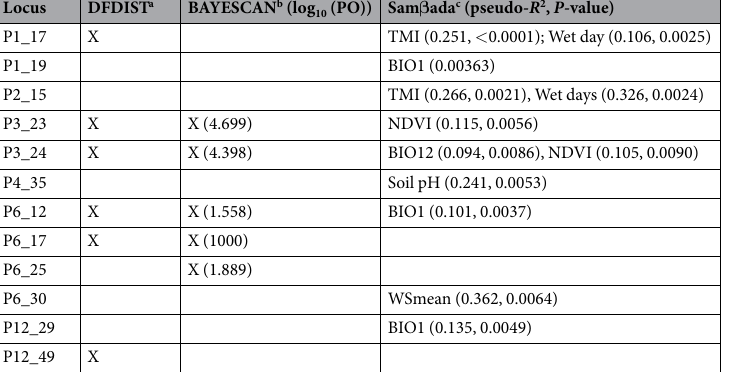
among haplotypes did not fit tightly with a population in the expansion model (Kolmogorov-Smirnov test, P < 0.001, Supplementary Fig. S1), which indicates diminishing populations or structured sizes of M. basjoo var. formosana 53, 54 . In un-subdivided populations, molecular signature characteristics of sudden expansions might not be observed, even when populations had expanded by several orders of magnitude after the LGM 55 . Although no consistent evidence for population growth was found for individual populations, our results showed evidence for historical spatial range expansion in pooled samples because of significant negative values of neutrality test statistics (Tajima’s D = − 1.6544, P = 0.015; Fu’s F s = − 6.8767, P = 0.008) (Table 2). Moreover, the hypothesis of historical spatial range expansion could not be rejected in pooled samples based on non-significant small rg value ( rg = 0.0697, P = 0.84) 32 , non-significant SSD (SSD = 00096, P = 0.81) 56 , and significant R 2 ( R 2 = 0.0416, P = 0.04) 33 (Table 2). Based on the average F ST value for each population in comparison with the remaining populations, glacial refugia of plant species have been inferred in many plant species in Taiwan. The most divergent populations can be found located in the north-central and south (particularly in the southeastern part) parts of Taiwan for tree species 6 . Populations served as refugia in the north-central part of Taiwan were found for tree species, including T. aralioides 17 , Cu. koinishii 57 , Ca. carlesii 18 , Machilus thunbergii 58 , Ma. Kusanoi 58 , and Ci. kanehirae 6 based on chloroplast DNA variation; and Ci. kanehirae 19 and Quercus glauca 59 based on nuclear DNA variation. Species with southern glacial refugia include Cy. glauca 15 , T. aralioides 17 , Ca. Carlesii 18 , Ma. thunbergii 58 , Ma. Kusanoi 58 , and Ci. kanehirae 6 based on chloroplast DNA variation; and Ci. kanehirae 19 and Q. glauca 59 based on nuclear DNA variation. Our results in M. basjoo var. formosana reflect recolonization events after the latest glacial period that probably originated from the southern population Sandimen due to its highest mean pairwise F ST ( = 0.154) against the remaining populations based on sequence variation of the second intron of Cu/Zn SOD2 (Fig. 3). However, the population Wulai had the highest average F ST based on AFLP variation (Fig. 3) and clearly distin- guished from other populations according to the DAPC genetic clustering analysis (Fig. 4), suggesting that the population Wulai may have been the northern glacial refugium for M. basjoo var. formosana . In comparison with other angiosperm species that occurred in Taiwan, M. basjoo var. formosana had lower nucleotide diversity in the Cu/Zn SOD2 second intron ( Hd = 0.628, θ π = 0.00119, and θ S = 0.00280) compared to introns of chalcone synthase ( Chs ) and leafy ( Lfy ) genes in Ci. kanehirae ( Chs : Hd = 0.841, θ π = 0.00716, and θ drogenase gene in Q. glacuca ( Hd = 0.840 and θ π = 0.00500) 59 . However, these comparisons may not be appropri- ate based on only one gene and the gene sequences compared between species were different. Nevertheless, the level of sequence nucleotide diversity reflects the past demographic events in natural populations. Although pop- ulations Sandimen and Wulai may have been the glacial refugia for M. basjoo var. formosana , populations Beishi, Shitou, and Wufeng located in north and central Taiwan across the CMR had higher levels of nucleotide diversity (Table 1). These results suggested that populations Beishi, Shitou, and Wufeng may be the melting pots of diver- sity 5 . However, the migration routes may have occurred mostly northward from the southern refugium (popula- tion Sandimen) and between adjacent populations except for the population Wulai; and scarcely southward from the northern refugium (population Wulai). This is because the population Wulai had a high average F ST ( = 0.274) in comparison with all other populations based on AFLP variation (Supplementary Table S1) and individuals of the population Wulai are clearly differentiated from individuals of all other populations (Fig. 4). Compared to other populations, the population Wulai is identified as potential refugium located in higher elevation because the rugged geographic topology might serve as an insular area for the survival of this population during the LGM. AFLP displayed higher level of genetic diversity (average H E = 0.276) in M. basjoo var. formosana compared with other broadleaf tree species occurred in Taiwan, such as Rhododendron oldhamii (average H E = 0.216) 11 and